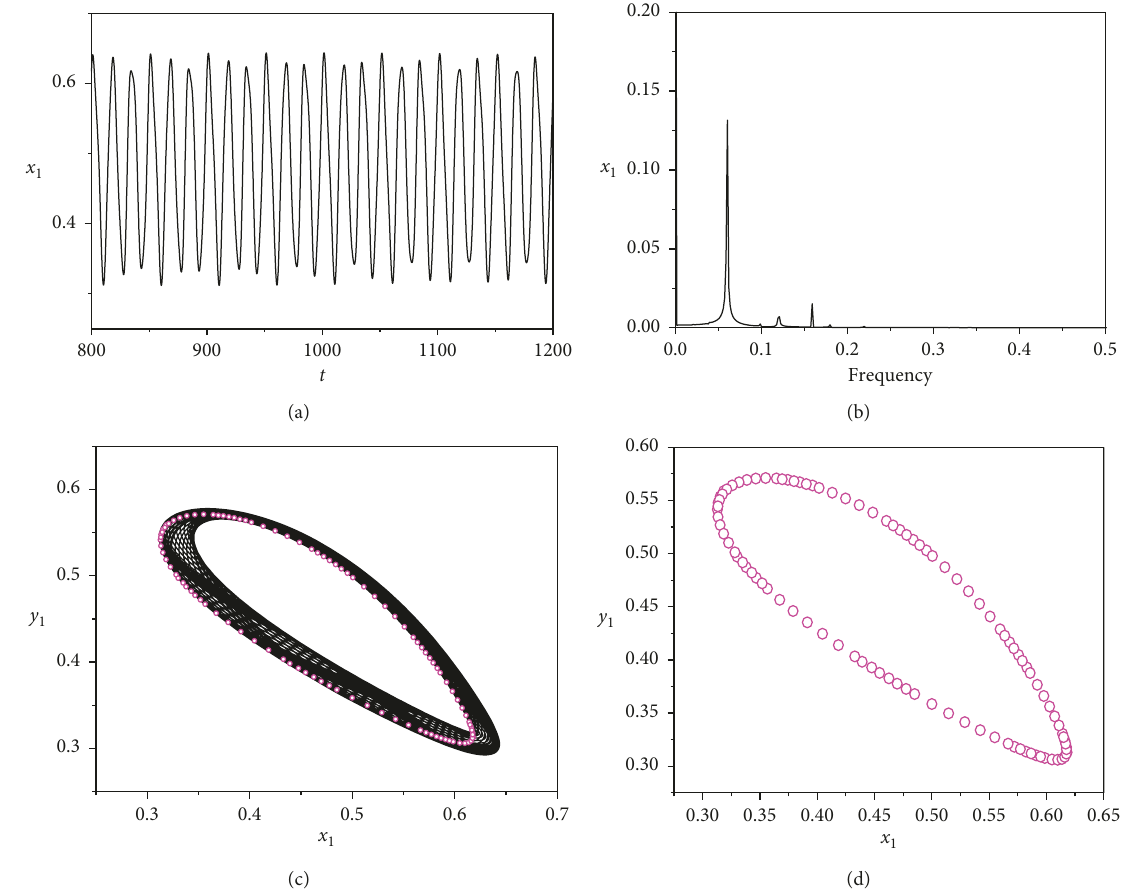
Figure 6: ω � 3.412: (a) displacement response; (b) frequency spectrum; (c) rotor orbit; (d) Poincar´e maps.